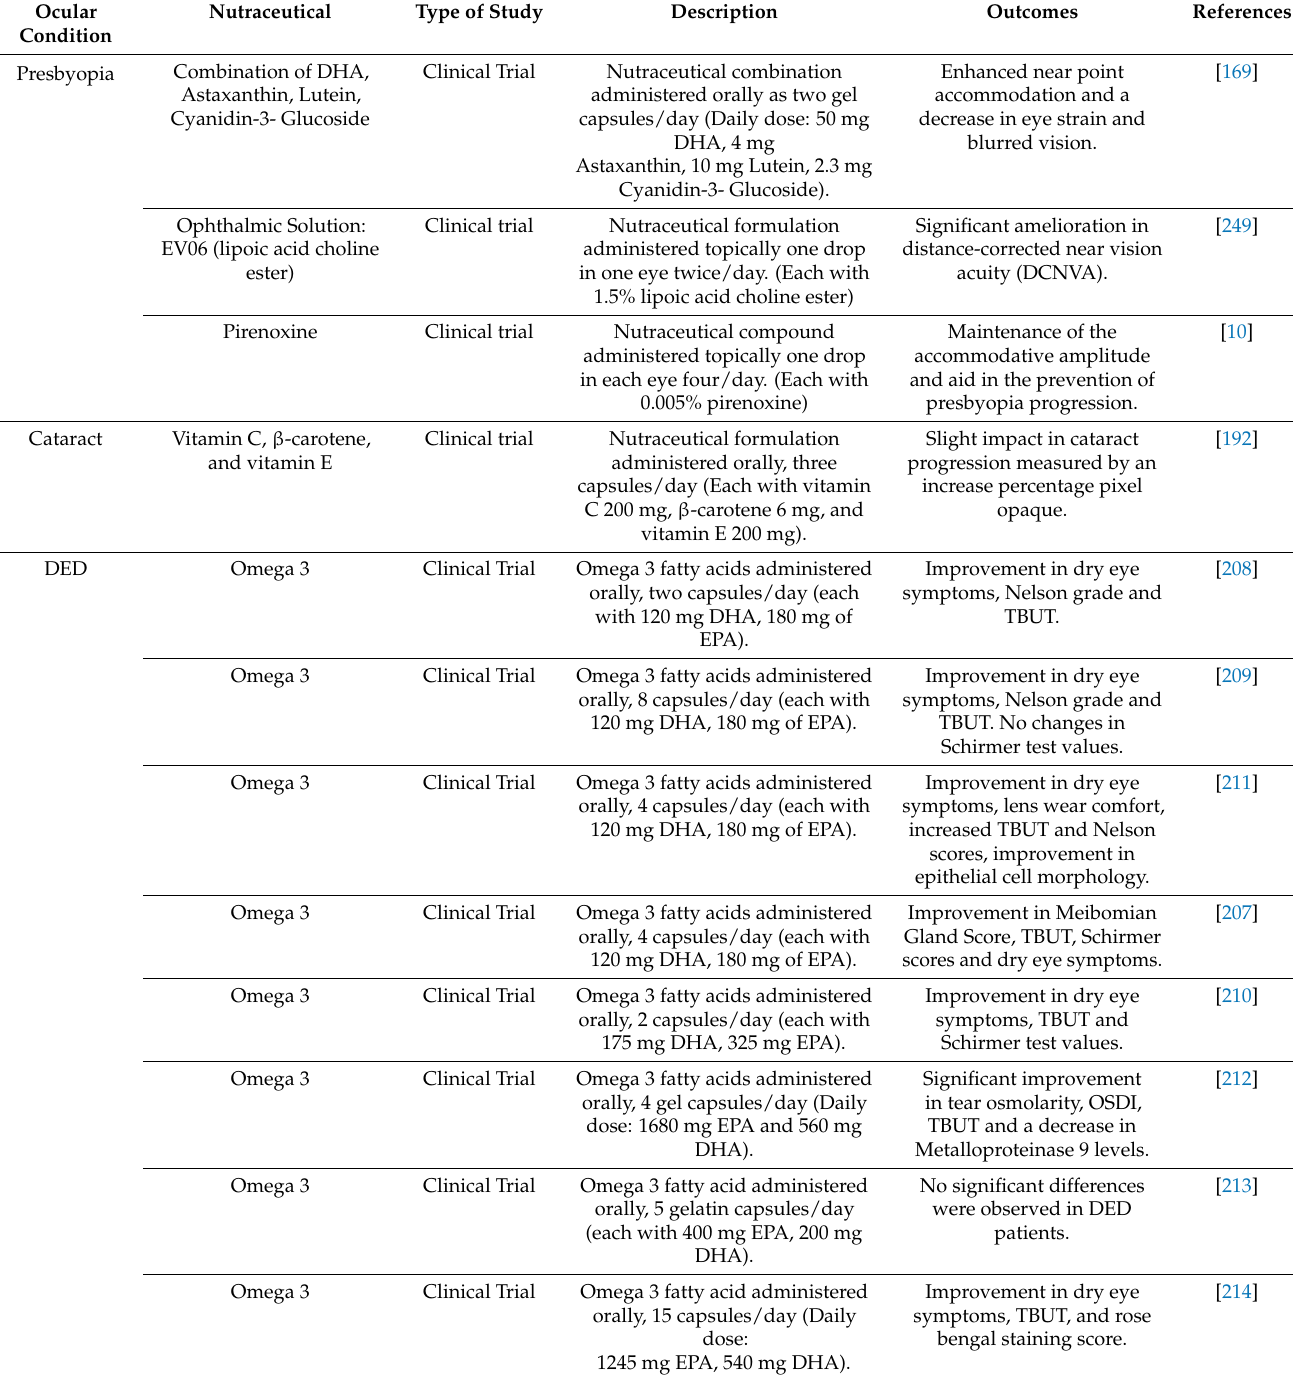
Table 1. Comparative table of the use of different nutraceuticals in